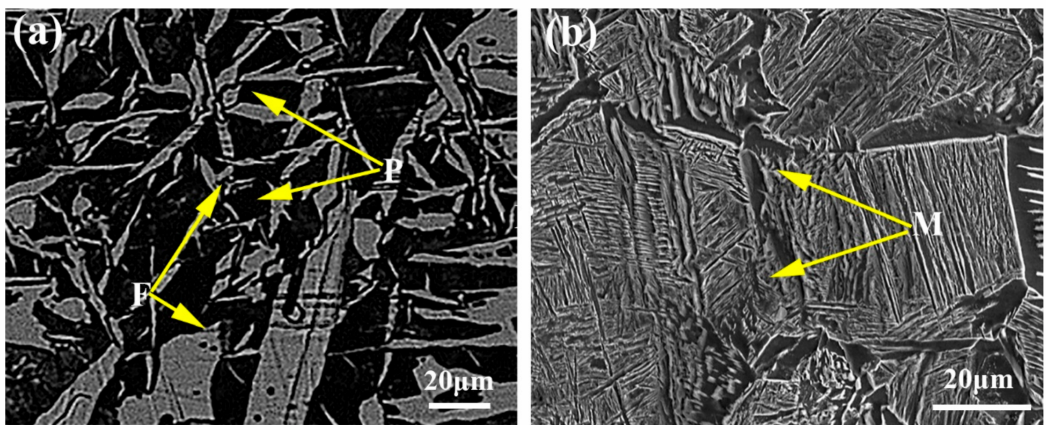
Figure 2. Optical micrographs of ( a ) as-received microstructure; and SEM micrographs of ( b ) the microstructure after annealing at 920 ◦ C for 60 min.